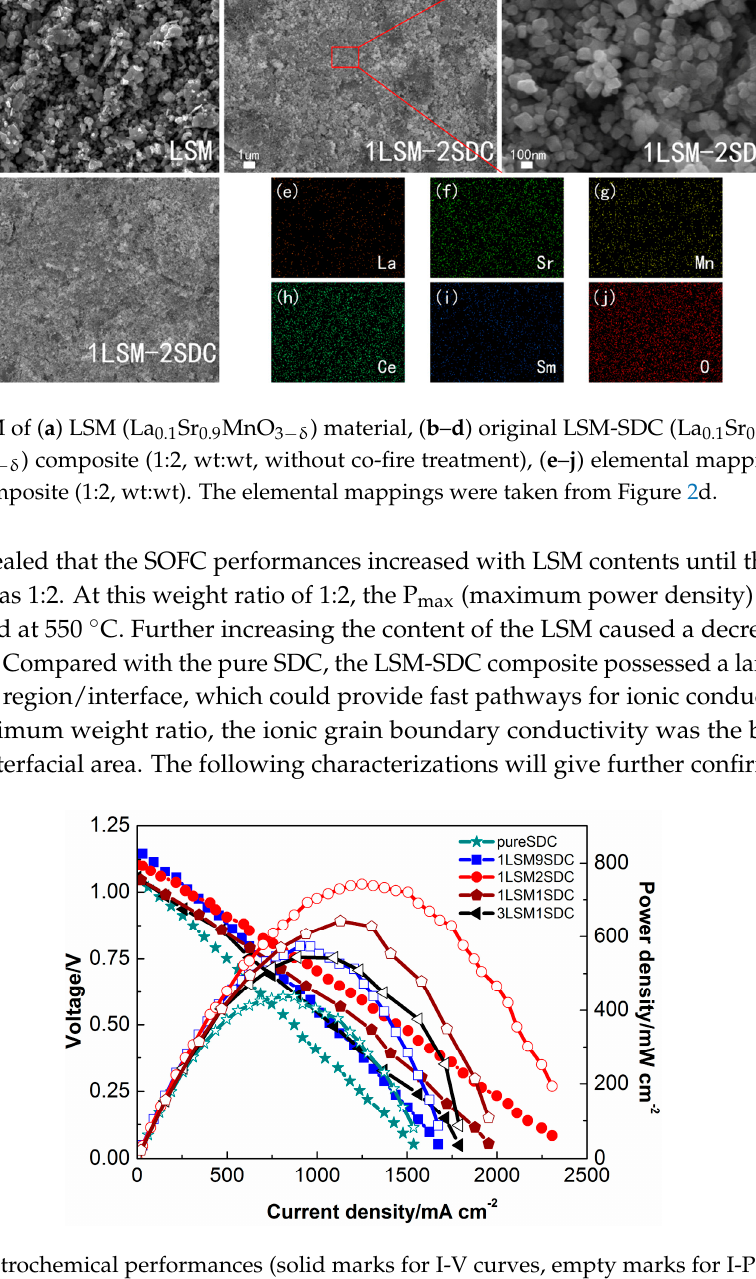
Figure 3. Electrochemical performances (solid marks for I-V curves, empty marks for I-P curves) of SOFCs based on LSM-SDC (La 0.1 Sr 0.9 MnO 3 −δ -Ce 0.8 Sm 0.2 O 2 −δ ) layer with various compositions.